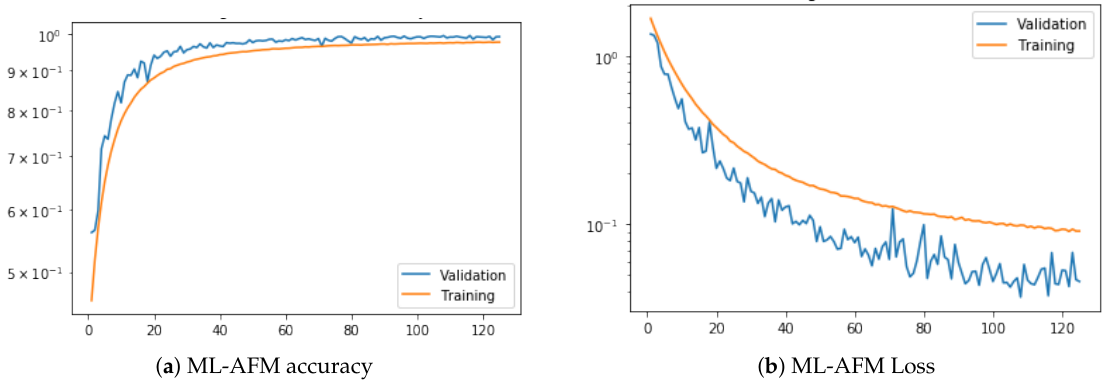
Figure A5. Loss and accuracy metrics of the ML-AFM model during training. The evaluation on the training data is shown in orange while the validation data are represented by the blue graph. The accuracy on validation data is better than on training data because the IDG is applied only to the training set. It should be noted that the effort made to prevent overfitting is reflected in the fact that the accuracy loss function has a slower growth than in the VGG16 and MobileNetV2 trainings. As a consequence, the model needs more epochs to adjust its weights but the training does not result in a too specialized model that is able to